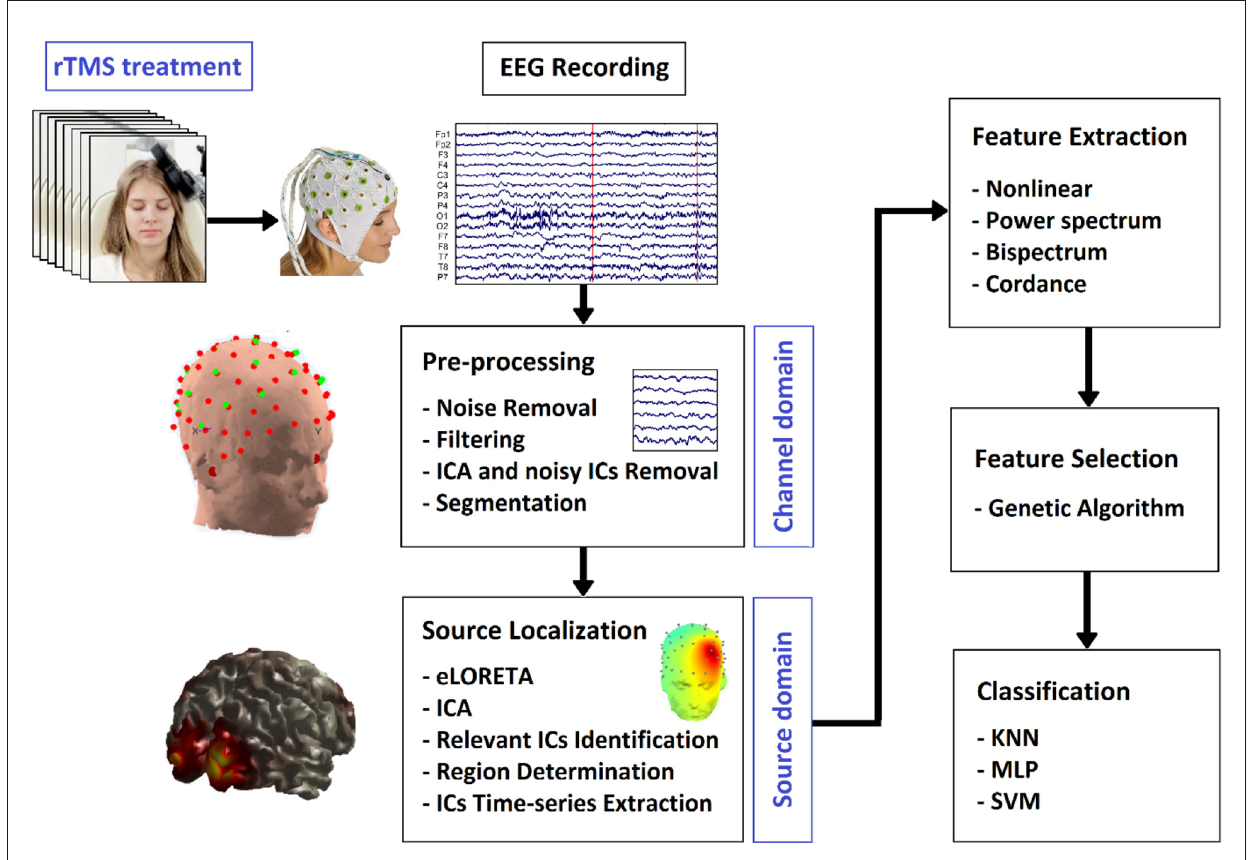
FIGURE1 Block diagram of the proposed approach for prediction of rTMS treatment response in MDD.